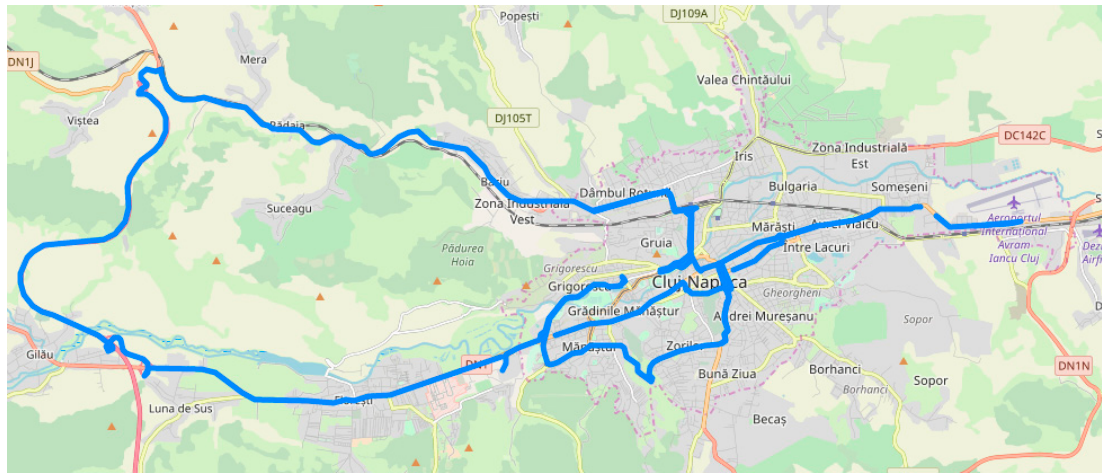
Figure 12. The GPS traces for all the trips recorded in Cluj ‐ Napoca, Romania, and the near surroundings.